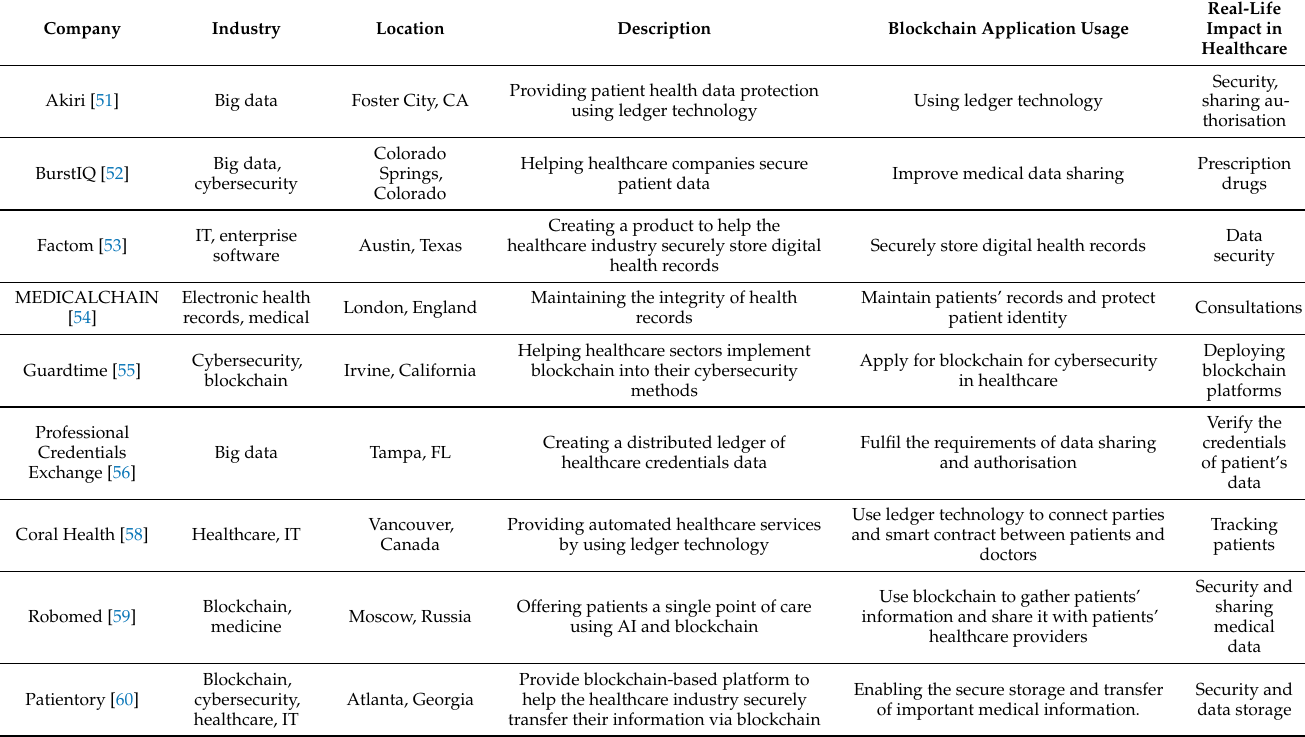
Table 6. Blockchain in the healthcare